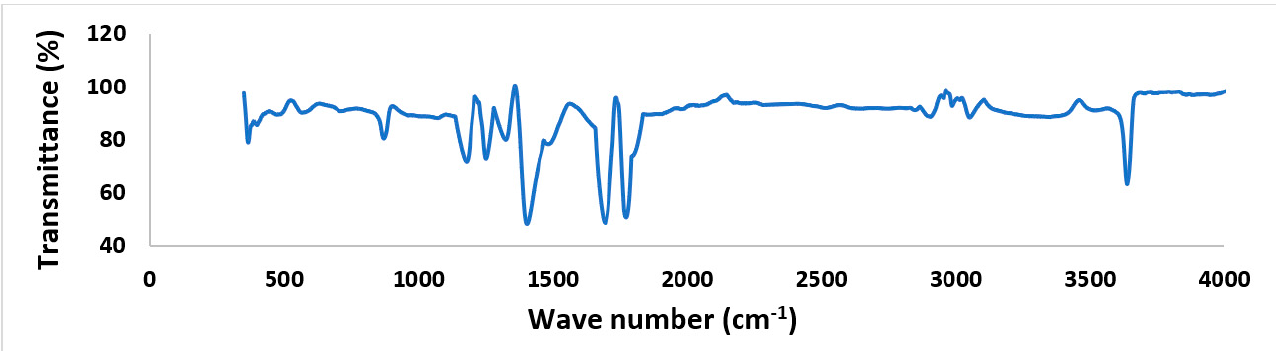
Figure 7. FTIR spectrum [CaCu(OCH 3 ) 2 ] catalyst.